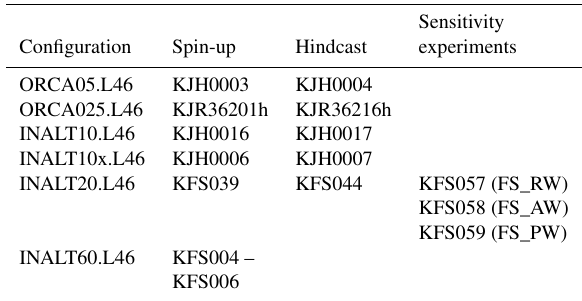
Table 3. To uniquely define the different model experiments, inter- nal experiment identifiers are provided